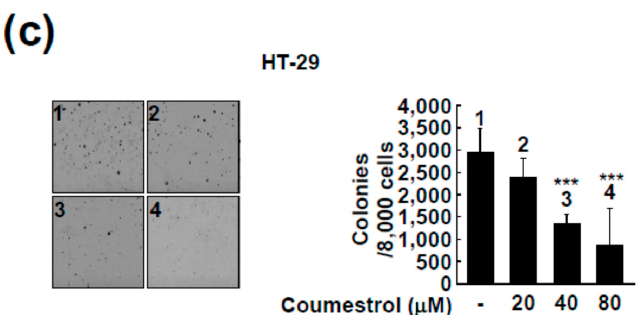
Figure 2. Inhibitory effect of coumestrol on anchorage-independent cell growth of lung cancer cells ( a ) and colon cancer cells ( b , c ). The detailed procedure is described in the Materials and Methods. Briefly, the colony formation of the cancer cells was tested with 0.3% agar matrix as the top layer with 0.6% agar matrix as the base layer. The colony formation was captured with the X 40 magnification. Data are representative of three independent experiments, which gave similar results. The asterisks (***) indicate a significant difference of p < 0.001 compared to the untreated group.